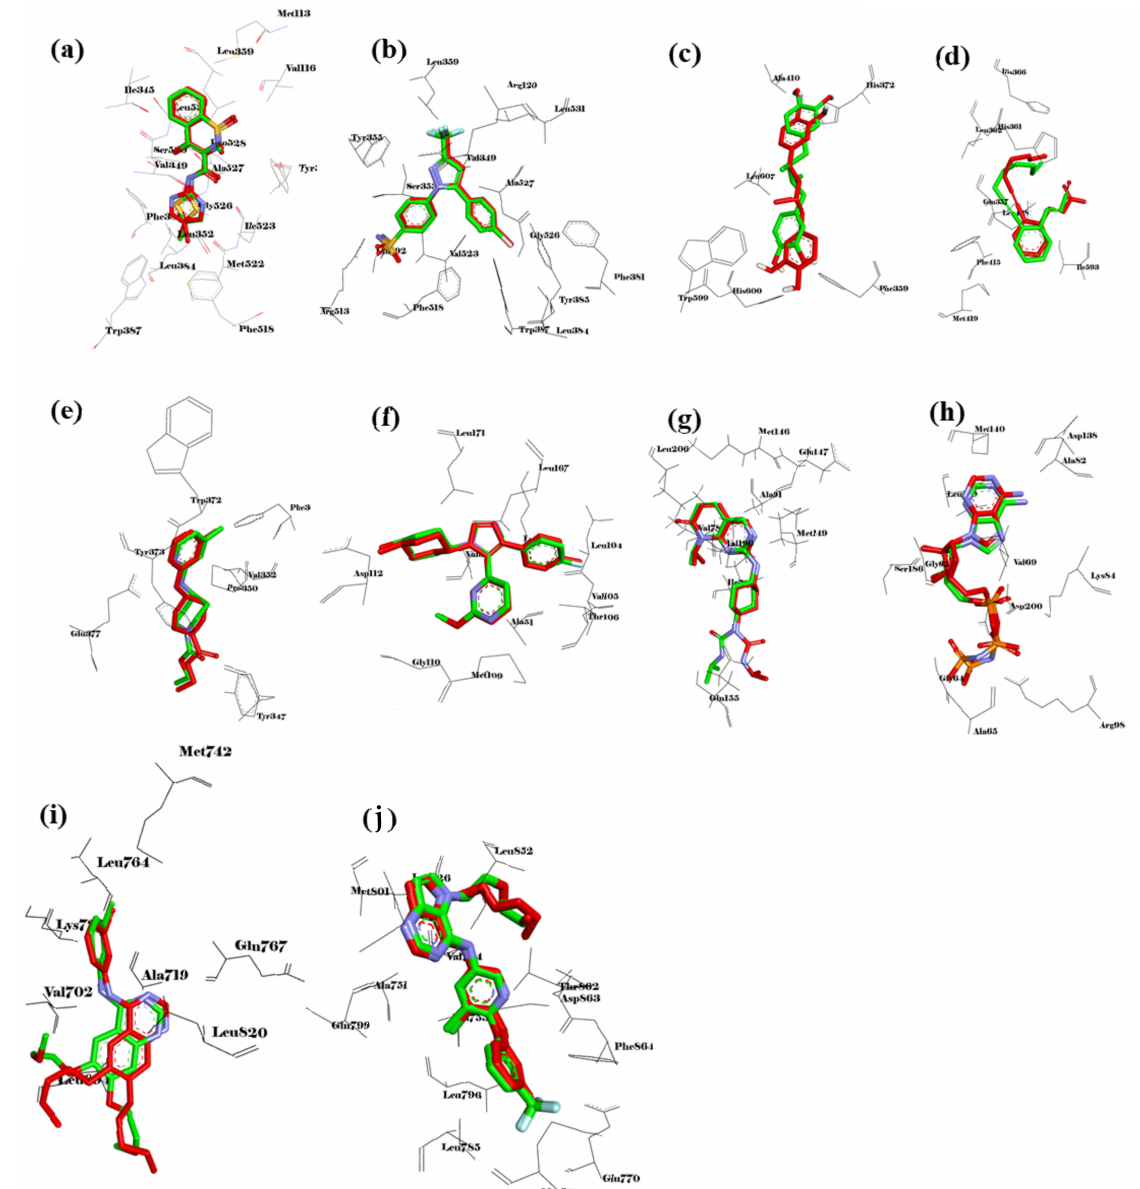
Figure 9. Validation of the molecular docking method. Overlay of redocked conformation (green car- bons) with co-crystalized conformation (red carbons) of ( a ) meloxicam to COX-1 (4O1Z), ( b ) celecoxib to COX-2 (6COX), ( c ) 30Z to 5-LOX (6N2W), ( d ) RS7 to ALOX15 (2P0M), ( e ) AT2 to iNOS (3E7G), ( f ) SB0 to p38MAPK (4FA2), ( g ) PDB ID:519 to JNK (4Y5H), ( h ) ANP to ERK5 (4IC7), ( i ) AQ4 to EGFR (1M17), and ( j ) 03Q to ERBB2